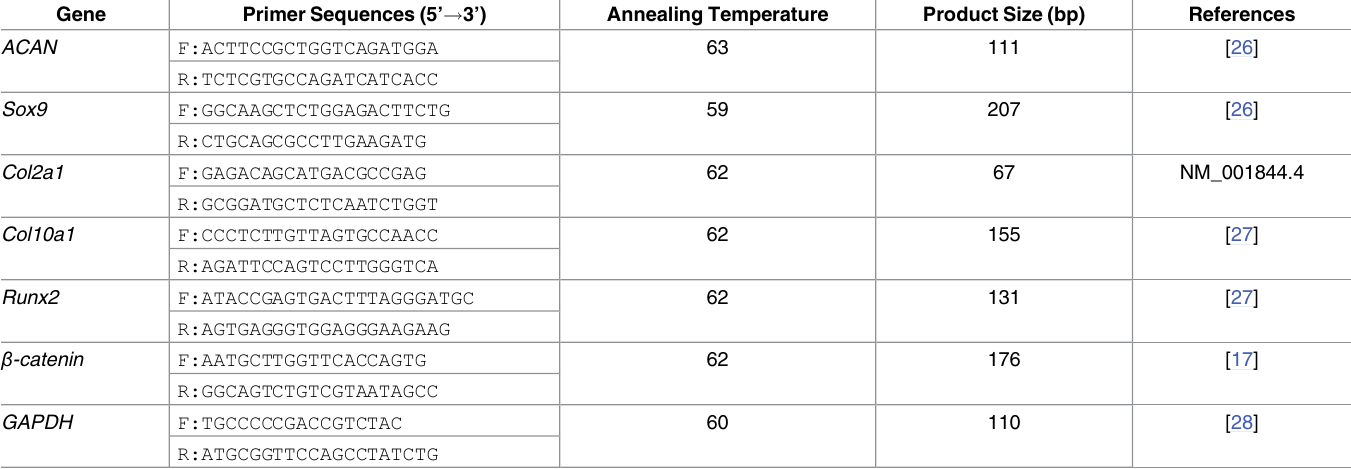
Table 1. Primers used for qPCR analysis.